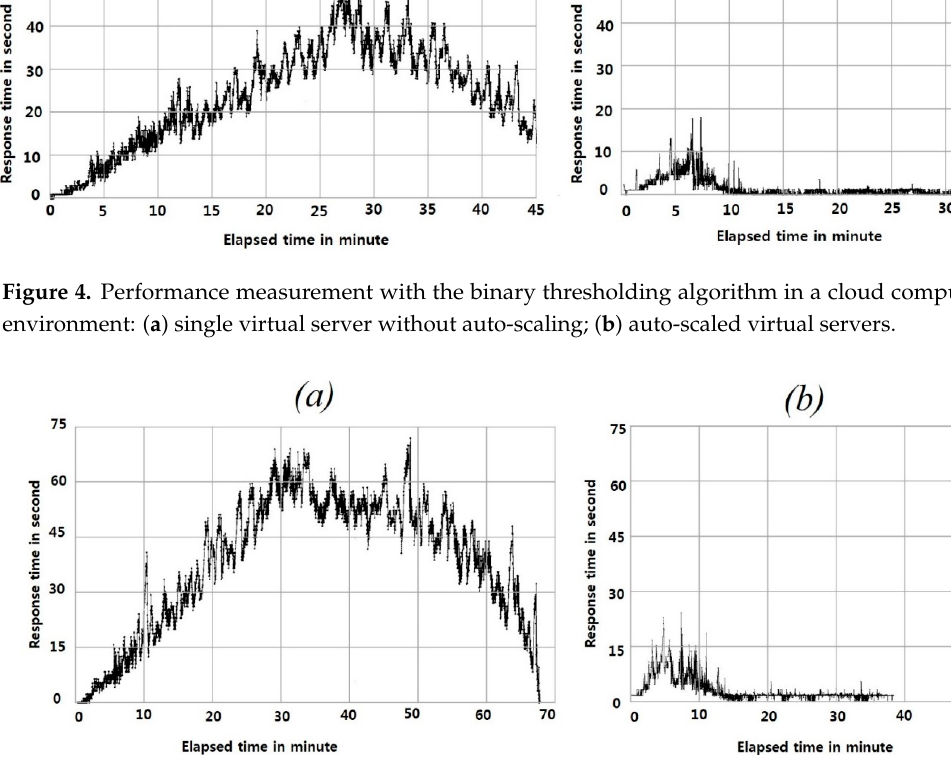
Figure 5. Performance measurement with the cloud detection algorithm in a cloud computing environment: ( a ) single virtual server without auto-scaling; ( b ) auto-scaled virtual servers.